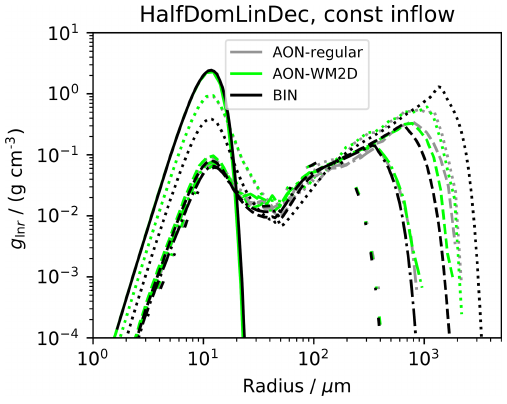
Figure 11. HalfDomLinDec set-up: size distribution g ln r for vari- ous model versions and times as in Fig. 10 (see legends